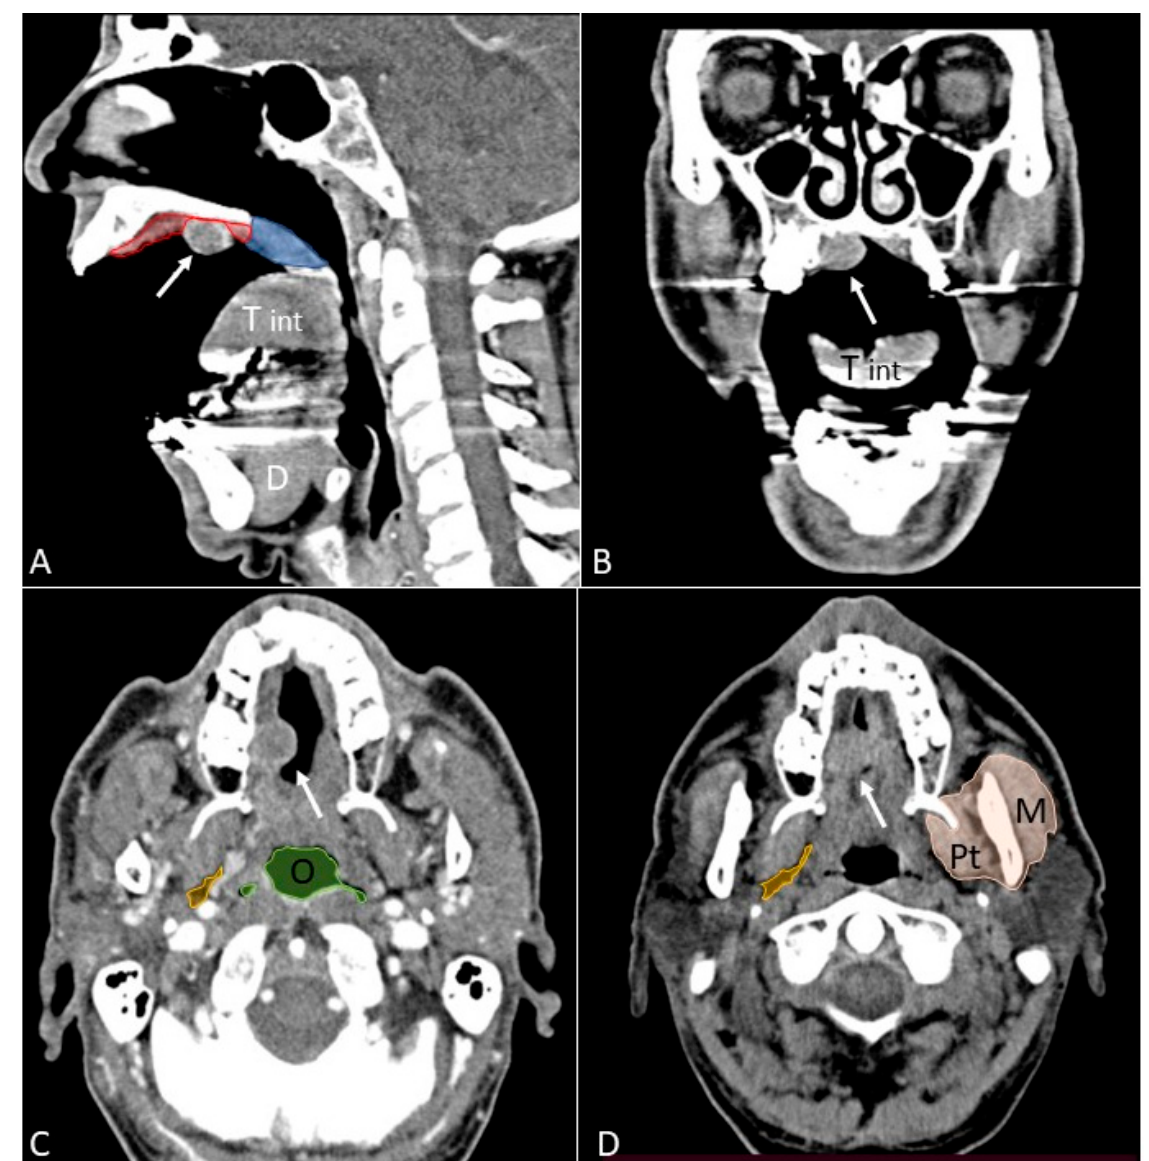
Figure 12. Open mouth MSCT technique. ( A ) Sagittal contrast-enhanced MSCT image showing clearly the lesion of the hard palate mucosa (arrow). The mucous lining of the hard palate (red) and soft palate (blue) are highlighted. The tongue appears different from conventional MSCT scans since with this technique the intrinsic musculature (T int) is retracted, and the digastric muscle is both contracted and thickened D. The other extrinsic muscles do not appear clearly distinguishable from each other. ( B ) Coronal contrast-enhanced image showing the neoplasm (arrow) and the intrinsic musculature of the tongue (T int). ( C ) Axial contrast-enhanced image depicts the neoplasm very well (arrow). Two head and neck spaces that are not part of the oral cavity but represent pathways of tumoural diffusion and inflammatory pathologies are highlighted: the parapharyngeal fat space (yellow) and oropharyngeal mucous space with air into the pharyngeal lumen (O, green). ( D ) Axial conventional MSCT image shows how the neoplasm is much less visible than the open mouth technique. A further space bordering the oral cavity is highlighted: the masticator space (pink) formed at this level by the masseter (M) and medial pterygoid (Pt) muscles. Yellow: parapharyngeal fat space.